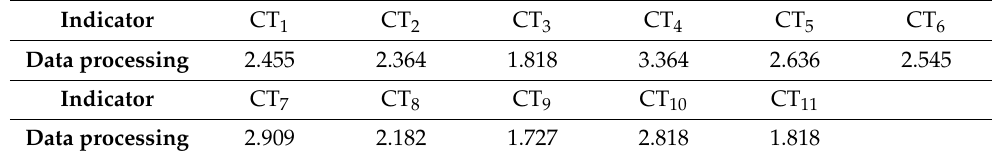
Table A2. Construction technical risk (CT) data processing.